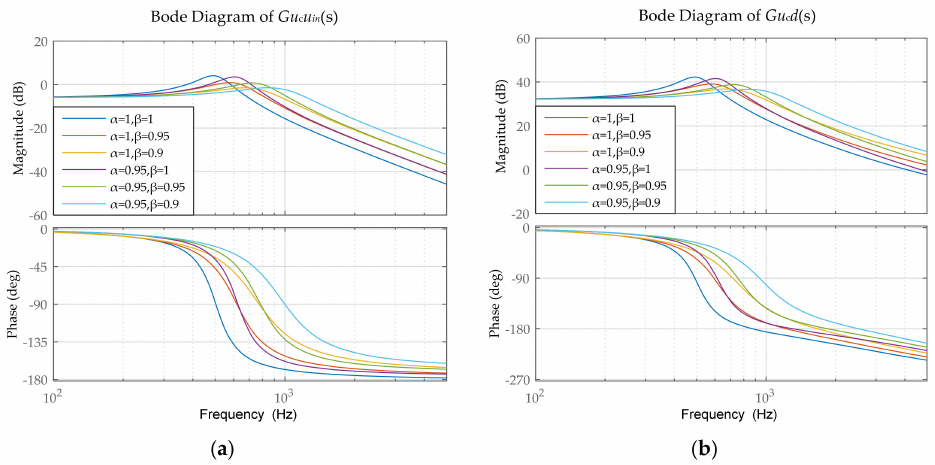
( s ) under di ff erent α and β . ( b ) The Bode diagram of G c u in